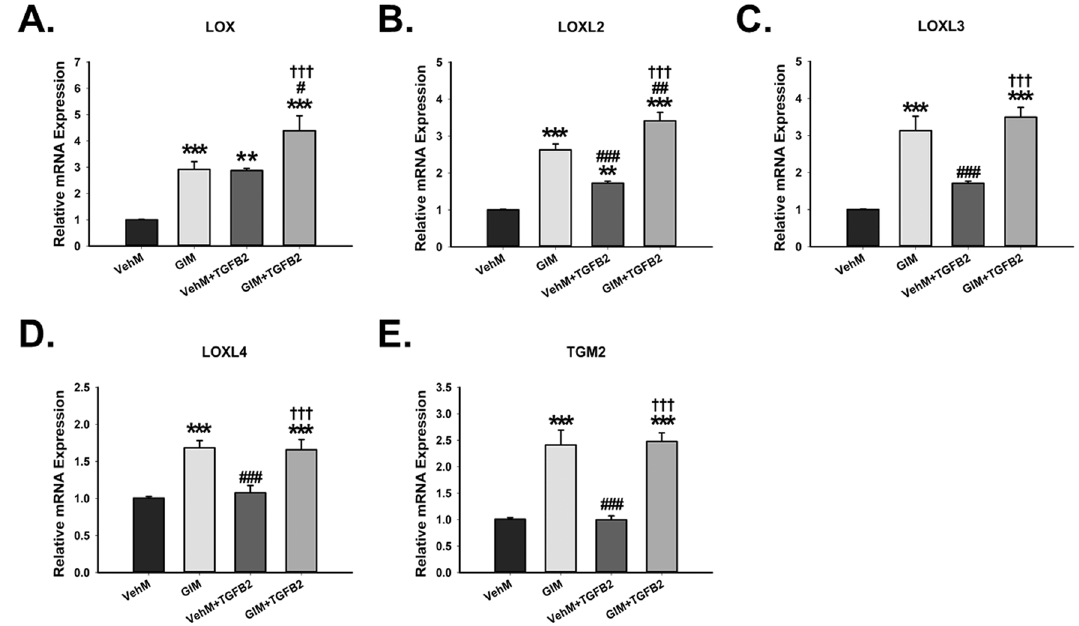
Figure 6. GIMs upregulate ECM crosslinking genes in the presence or absence of exogenous TGFβ2 in hTM cells. Primary hTM cells were cultured in the presence or absence of 100 nM dexamethasone for 4 weeks in complete growth media. Cells were subsequently removed using 20 mM ammonium hydroxide solution to obtain GIMs and vehicle control matrices (VehMs). Same strain, fresh primary hTM cells were then seeded on these matrices with or without exogenous 5 ng/ml TGFβ2 in 1% fetal bovine serum growth media for 7 days. RNA was extracted for reverse transcription and qPCR. GAPDH was used as an internal control for normalization. Bar graph for the gene expression of (A) Lysyl Oxidase (LOX), (B) Lysyl Oxidase- Like 2 (LOXL2), (C) Lysyl Oxidase-Like 3 (LOXL3), (D) Lysyl Oxidase-Like 4 (LOXL4), and (E) Tissue transglutaminase 2 (TGM2). Columns and error bars ; means and standard error of mean (SEM). One-way ANOVA with the Tukey pairwise comparisons post hoc test was used for statistical analysis. (n = 4